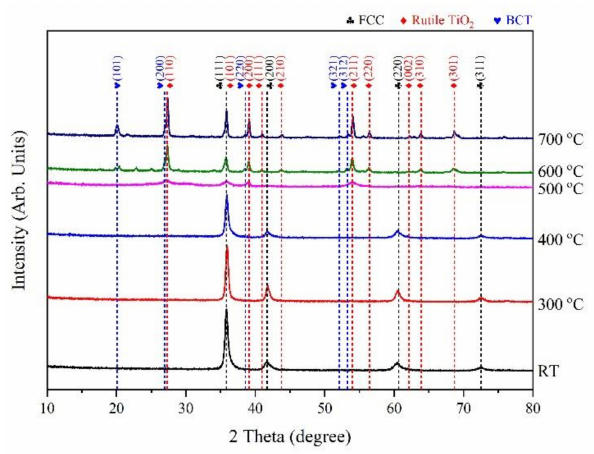
Figure 2. X-ray di ff raction patterns of (CrTaTiVZr)N coatings after annealing at di ff erent temperatures in